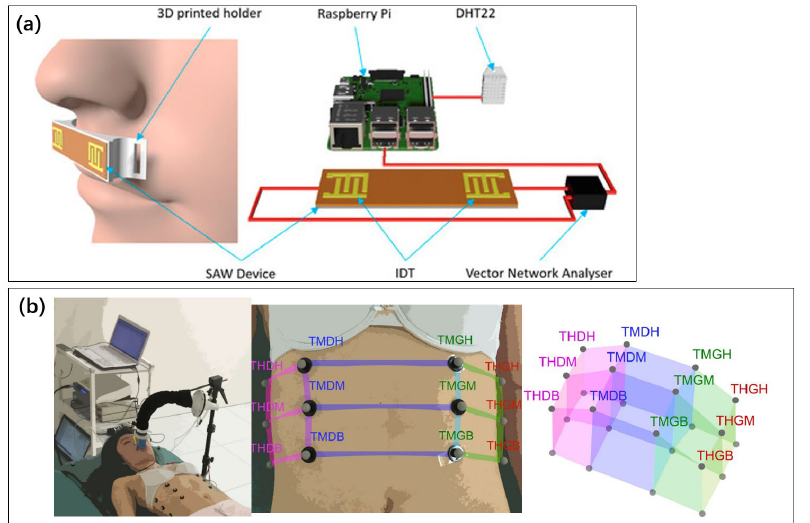
Figure 13. ( a ) Surface acoustic wave sensors [171]. Reproduced under the terms of the CC-BY Creative Commons Attribution License, Copyright 2022 by the authors, published by AIP Publishing. ( b ) A method for measuring thoracic volume using chest marker loci [176]. Reproduced under the terms of the CC-BY Creative Commons Attribution License, Copyright 2022 by the authors, published by Springer